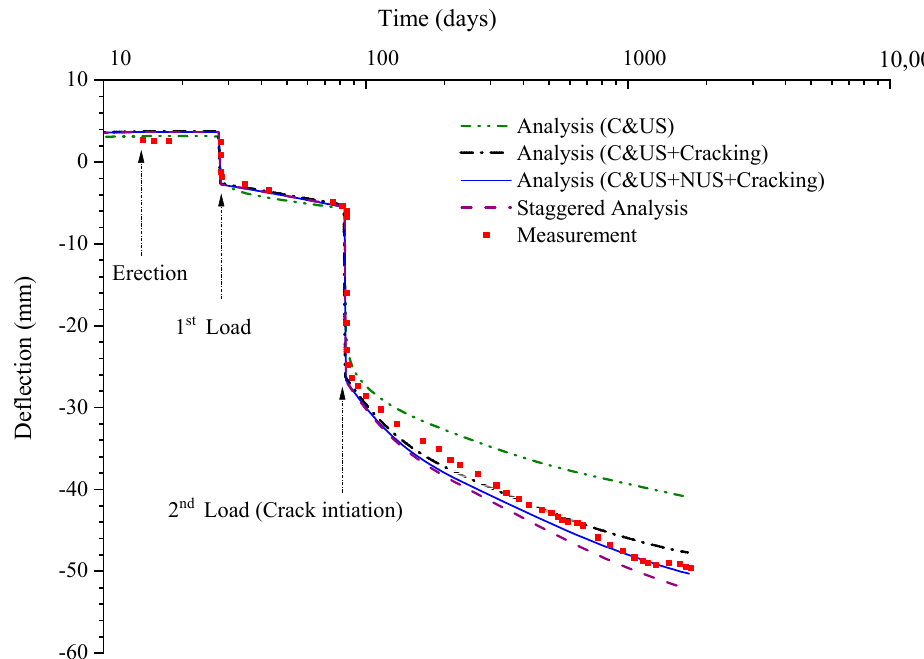
Figure 7. Variation of mid-span deflection of the short-span PSC beam.